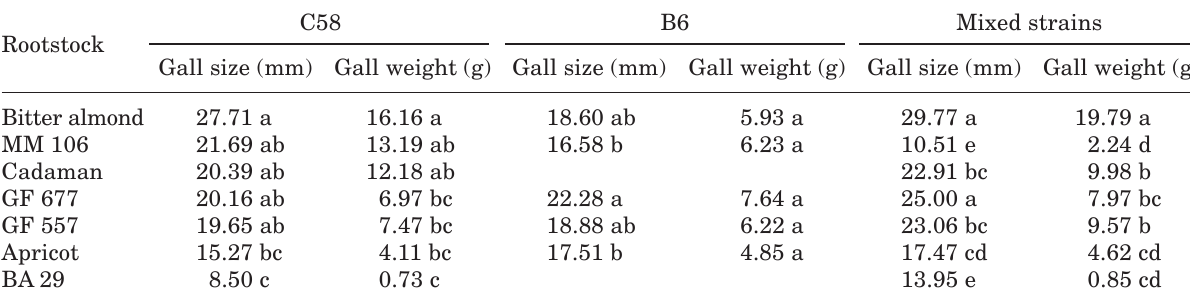
Table 3. Gall size and weight after root inoculation (2001 experiment) (average data). C58 B6 Mixed strains